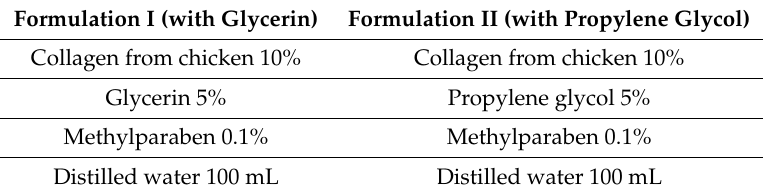
Table 2. Formulation of bio-therapeutic film of collagen from